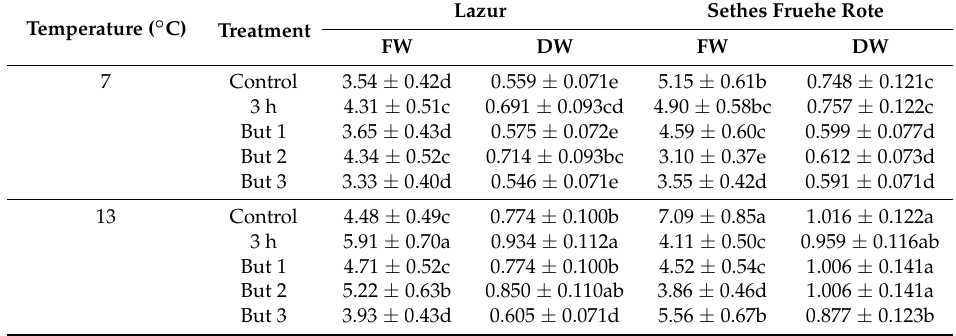
Table 4. Effects of pre-sowing treatments on fresh (FW) and dry weight (DW) [g] of two L. angustifolius cultivars germinated and grown for the first four weeks at 7 ◦ C or 13 ◦ C. Control—plants grown from seeds germinated in water; 3 h—plants grown from seeds hydroprimed for 3 h at 20 ◦ C; But 1, But 2, But 3—plants grown form seeds germinated in the presence of 10 − 6 M, 10 − 5 M, 10 − 4 M butenolide, respectively.